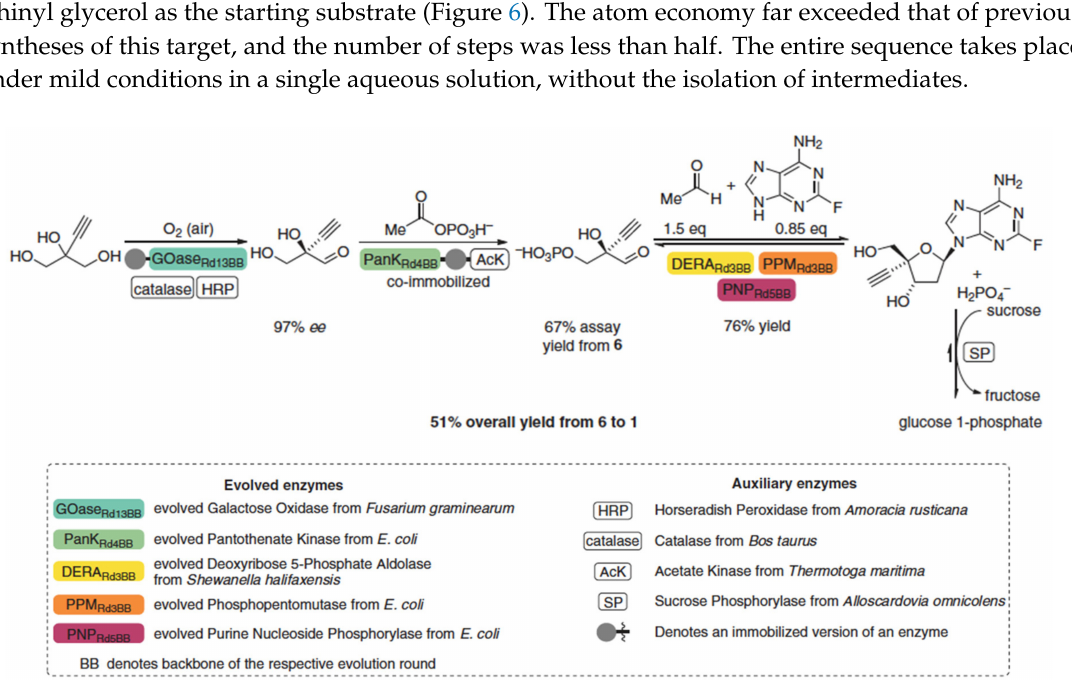
Figure 6. Multi-enzymatic synthesis of islatravir. Figure printed from Ref. [46]. Copyright © 2020, American Association for the Advancement of